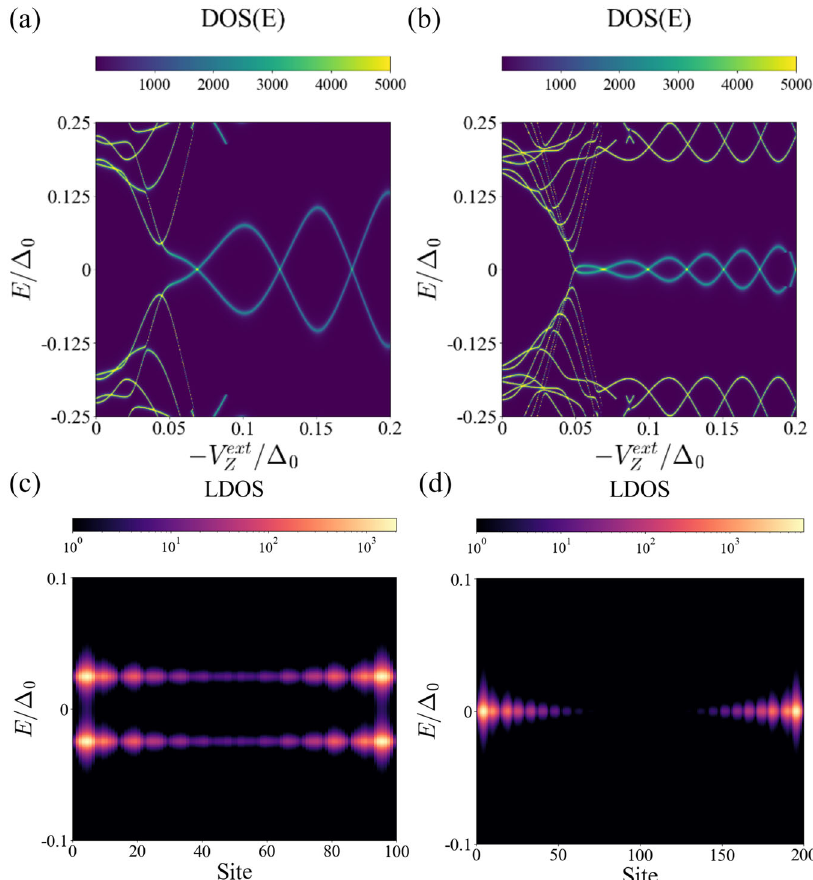
Fig. 2 Majorana Zero Modes (MZMs) in the structure. a , b Density of states (DOS) as a function of the energy(E) and the externally applied Zeeman fi eld V ext μ m, and b 4.5 μ m. The low energy DOS shows the gap closing, followed by the emergence of a Z of the device region for nanowire (NW) lengths a 2.25 state near zero energy. The splitting of this low energy state is greater for shorter nanowires than longer nanowires. c , d Local density of states (LDOS) pro fi les at V ext Z ¼ 0 : 1 Δ 0 which clearly show the localization of the zero energy states at the ends of the nanowire, consistent with the appearance of MZMs. The longer (length 4.5 μ m) nanowire d shows a greater degree of localization than the shorter (length 2.25 μ m) nanowire c . The bare superconducting gap in the parent superconductor Δ 0 sets the scale for all energies. The colorbars represent the magnitude of the DOS, LDOS.